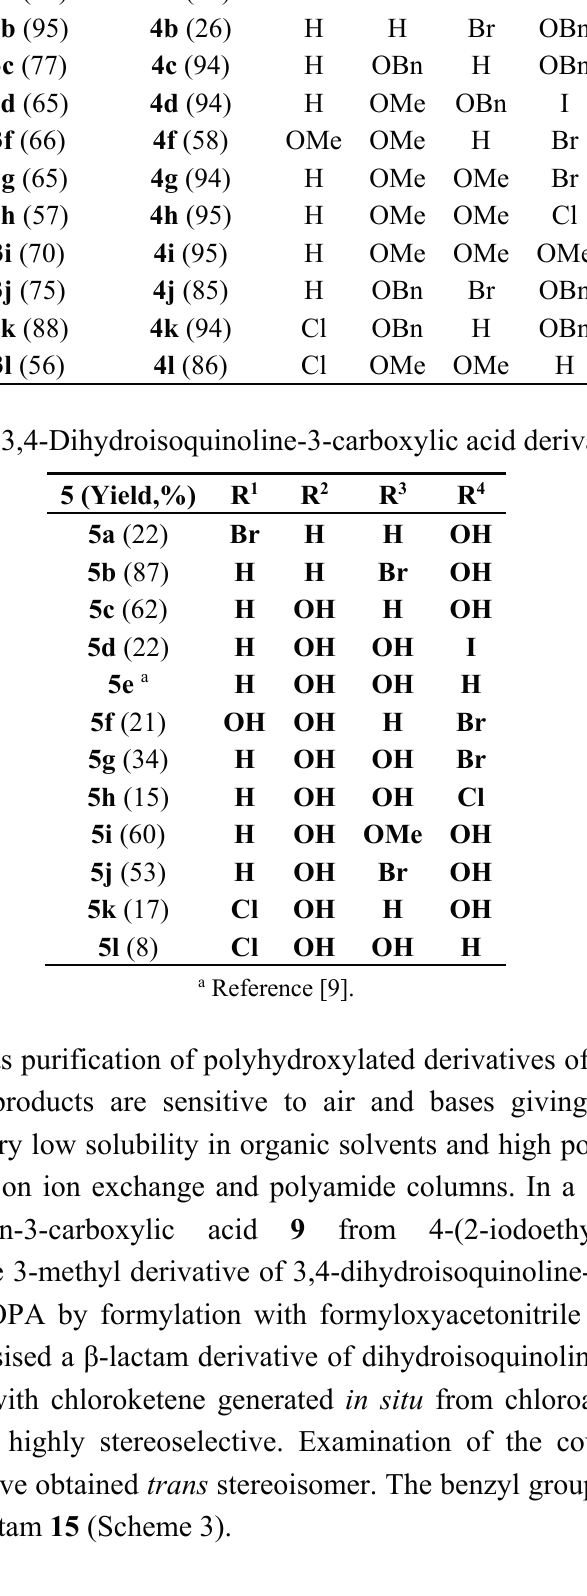
Table 1. Formamidomalonates 3 and 3,4-dihydroisoquinoline derivatives 4 . 3 (Yield,%)